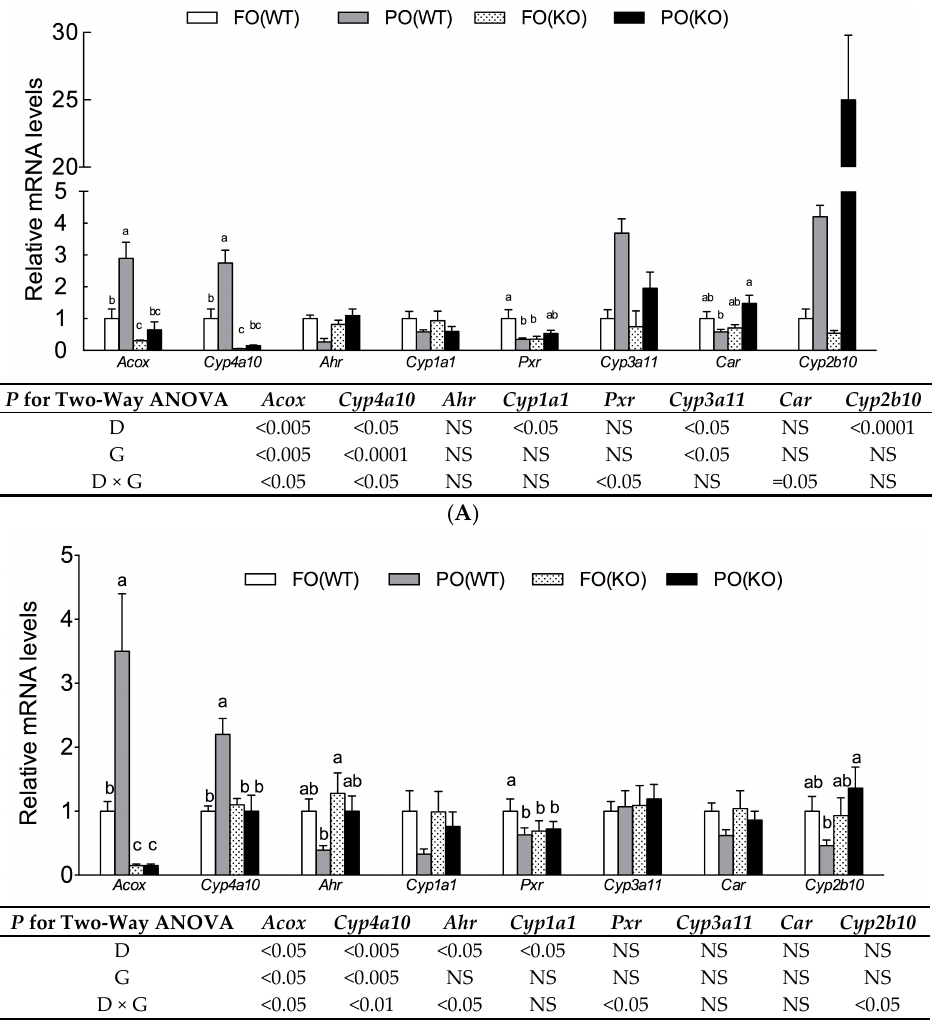
Figure 3. Levels of mRNA for genes associated with xenobiotic receptor activity in maternal liver ( A ) and fetal liver ( B ) of WT and KO mice receiving FO or PO diets during pregnancy. Samples were